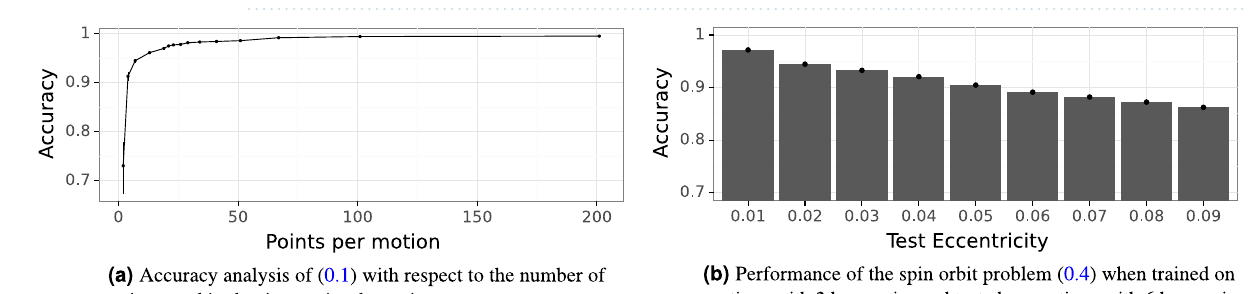
Figure 9. Results of cartography completion (extrapolation experiment). All maps correspond to (3), with ε = 0.01 .